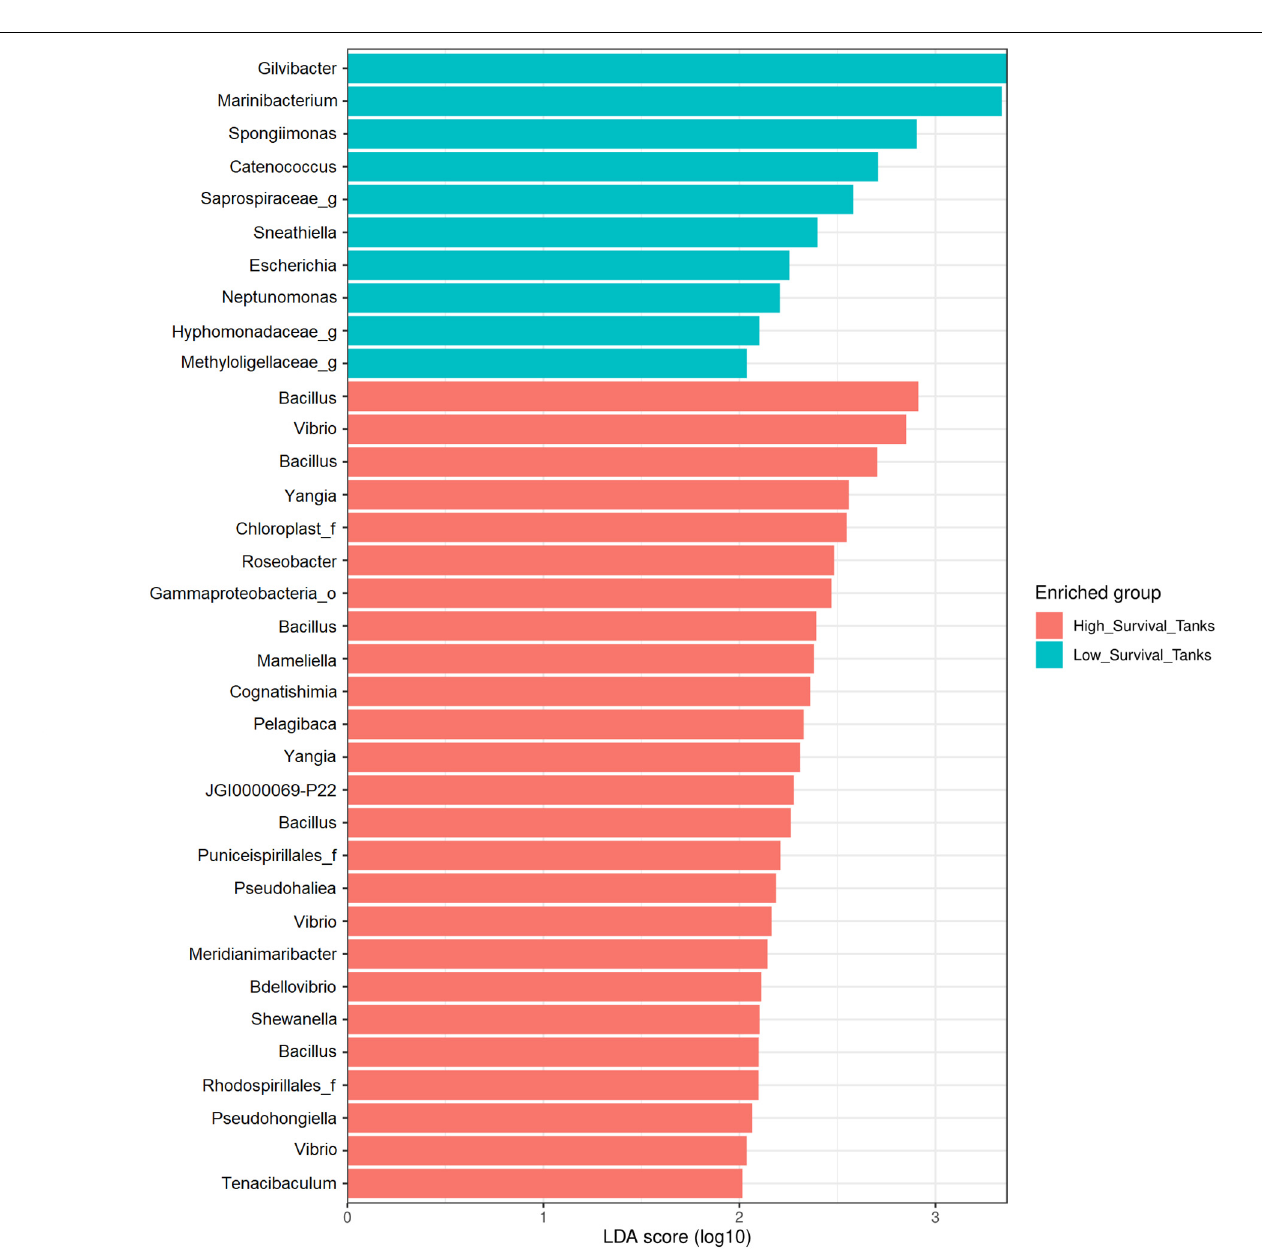
FIGURE 6 | Results of the differential abundance analysis using a linear discriminant analysis (LDA) effect size (LEfSe) of larvae collected from the high- and low-survival tanks affected with AHPND. The length of the bar represents the effect size (LDA cutoff = 2) of all the bacterial lineages at the genus level.